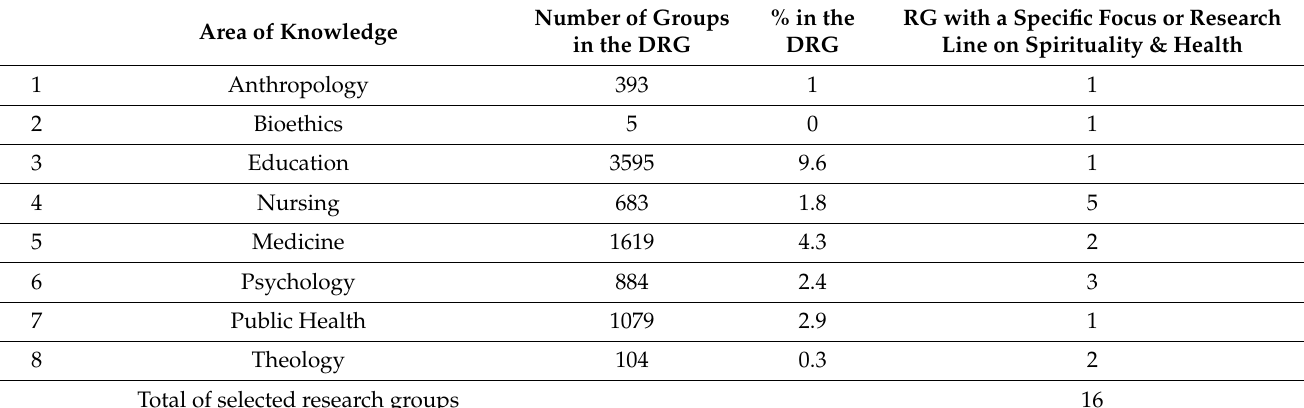
Table 1. Distribution of research groups according to the predominant area of knowledge in the group’s activities. Number of Groups Area of Knowledge in the